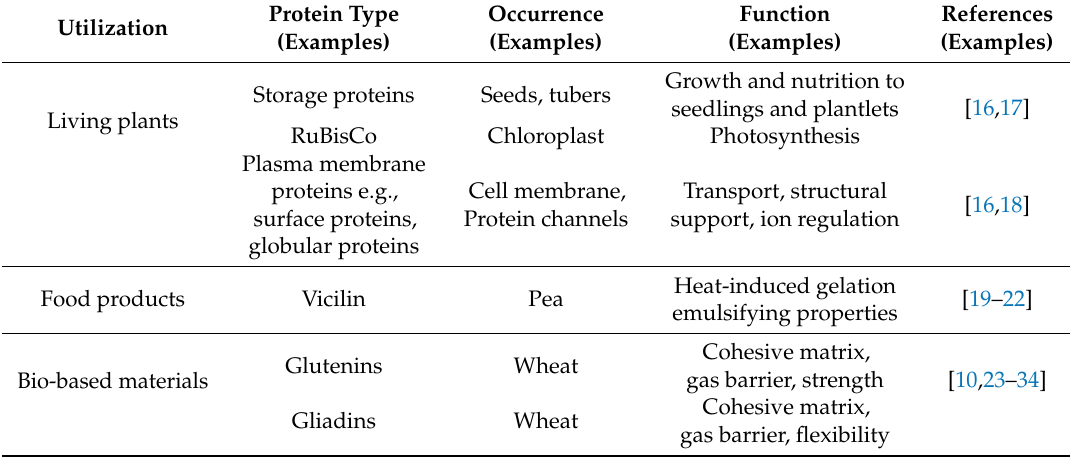
Table 2. Examples of plant proteins with their unique functions in plants, and in food